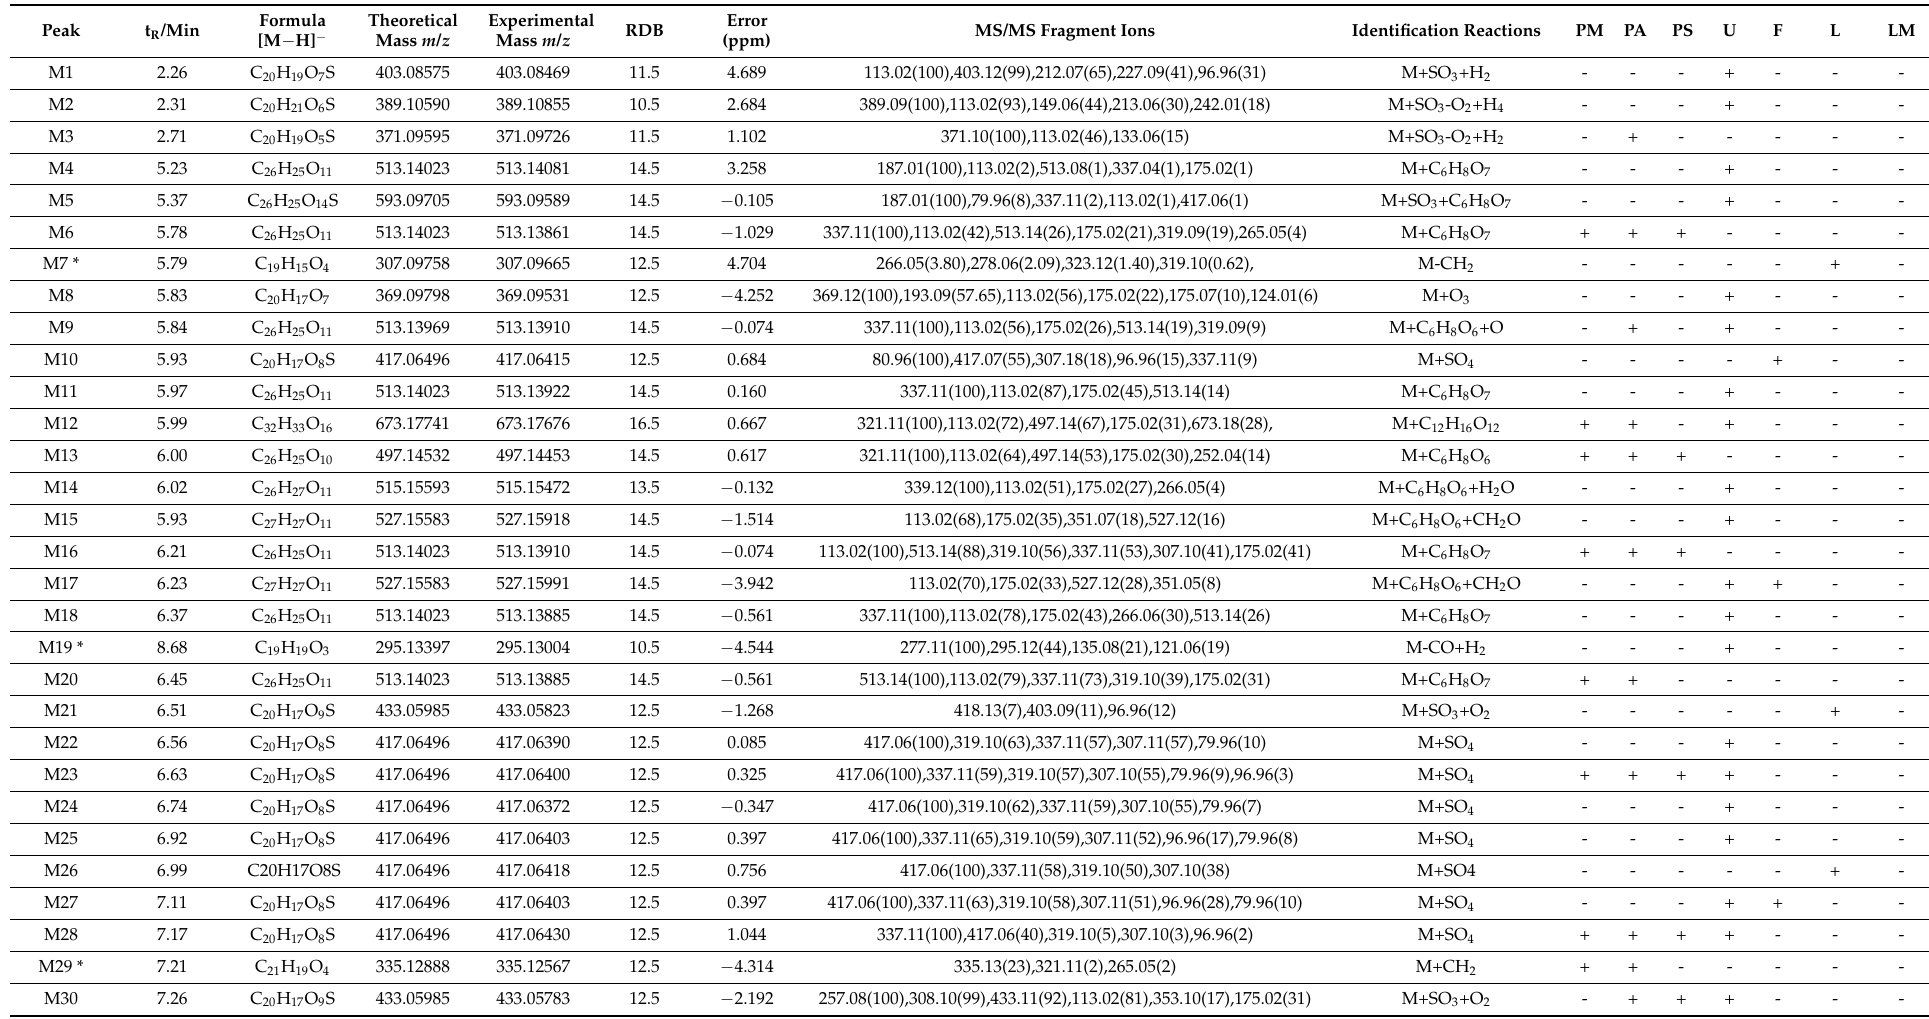
Table 2. Summary of neobavaisoflavone metabolites in rats plasma, urine, feces, liver, and liver